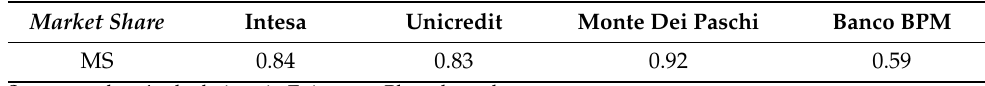
Table 5. Market Share: period of January 2015–December 2021.